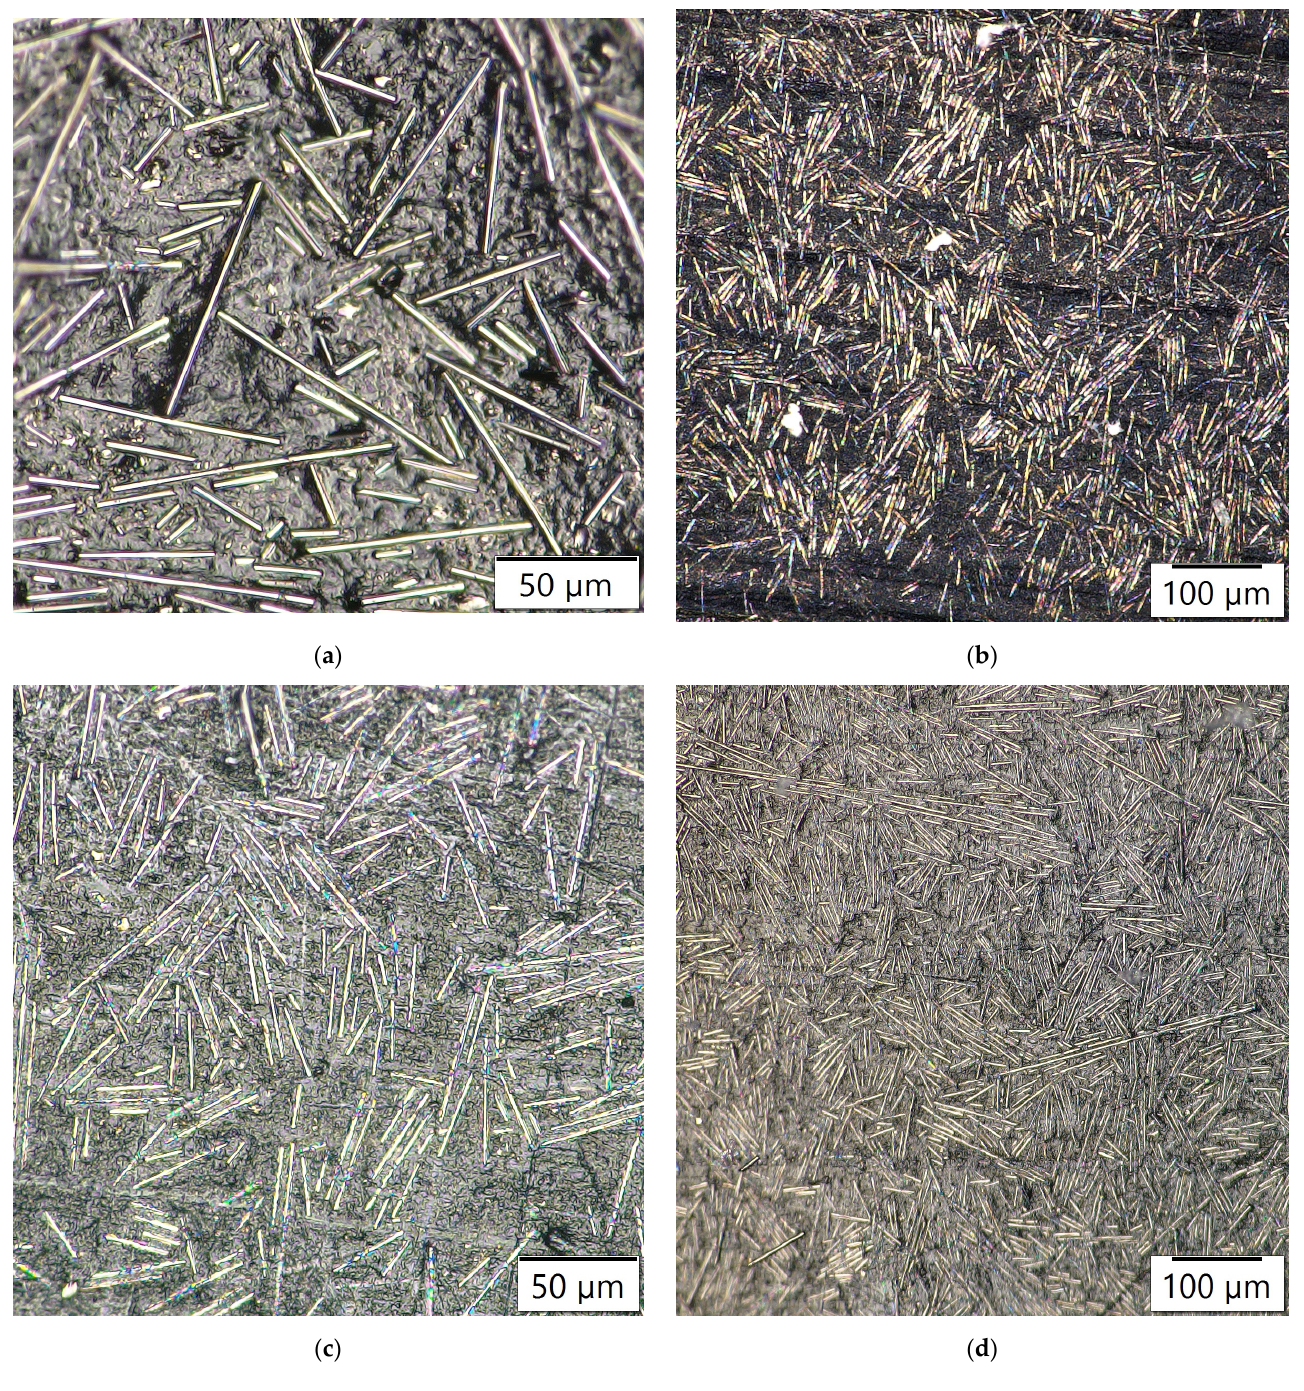
Figure 15. Surface images using optical microscopy: ( a , b ) 10% CF/non-plasma PE and ( c , d ) 10% CF/plasma PE combinations.